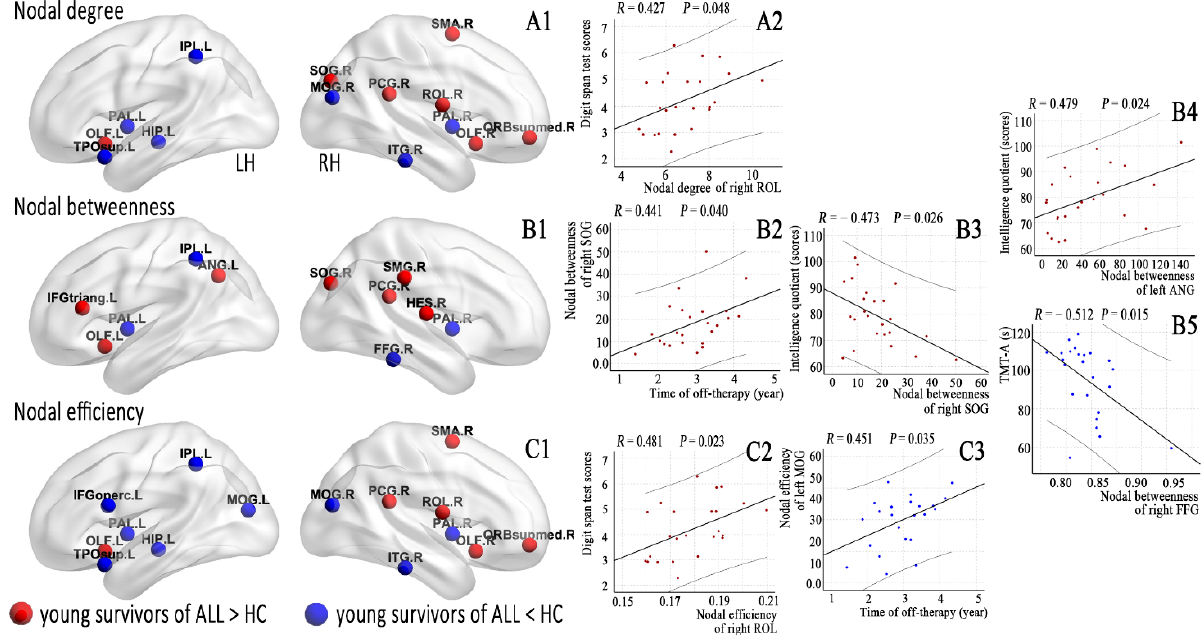
Figure 3. Brain regions with abnormal nodal centralities ( A1 , B1 ) and efficiency ( C1 ) in the morphological brain networks were compared between the young survivors of ALL and controls (FDR corrected, p < 0.05) and ( A2 , nodal degree; B1 – B5 , nodal betweenness; C2 , C3 , nodal efficiency) correlated with the clinical variables in the young survivors of